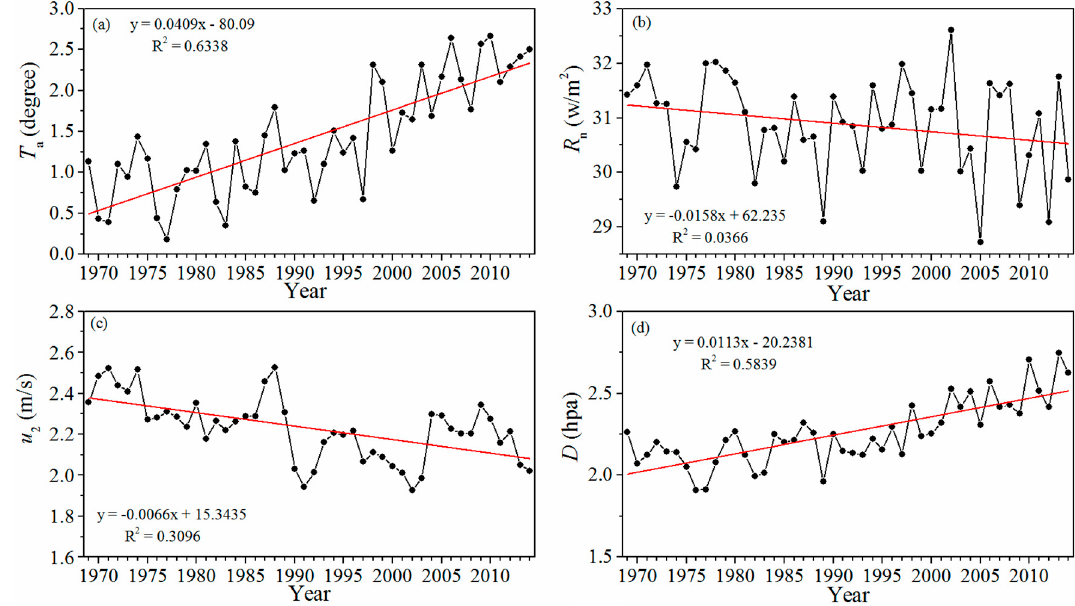
Figure 3. Arithmetic average of ( a ) annual air temperature ( T a ), ( b ) annual net radiation ( R n ), ( c ) annual wind speed two meters above ground ( u 2 ), and ( d ) annual water vapor pressure deficit ( D ) from the four stations in the Zoige wetland.